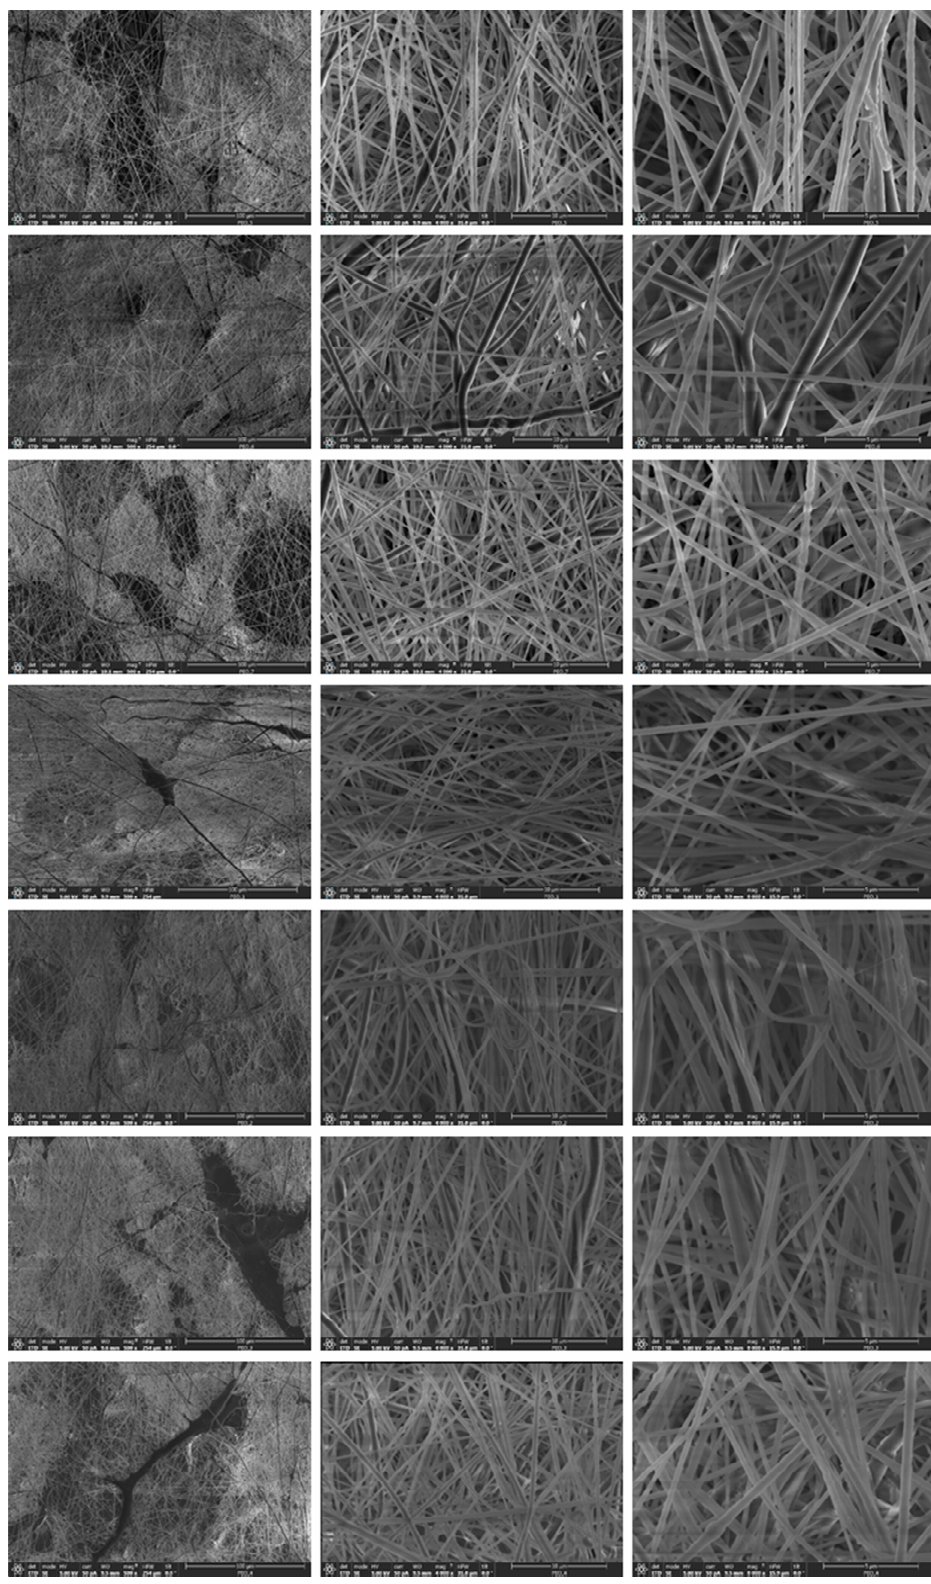
Figure 5. FESEM images of the blow spun fibers at different magnifications. Columns (left to right) represent the magnification, 500×, 4000× and 8000×. Rows (top to bottom) correspond to PEO-46, PEO-55, PEO-64, PEO-73, PEO-82, PEO-91AND PEO-100.